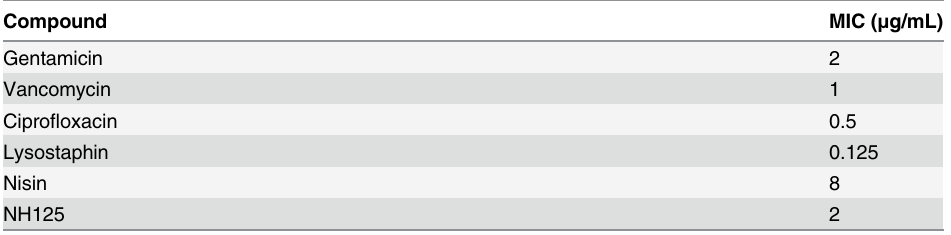
Table 1. Minimal inhibitory concentration (MIC) against S . aureus